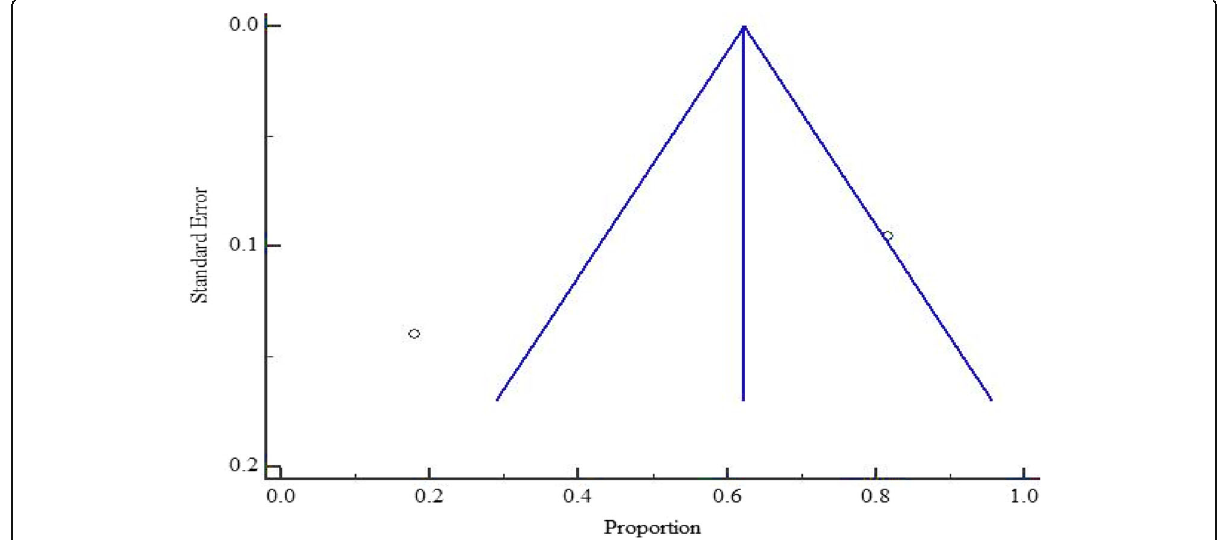
Fig. 8 Bias assessment plot of studies that reported bacterial contamination in herbal medicines sold in Tanzania from the year 2000 to